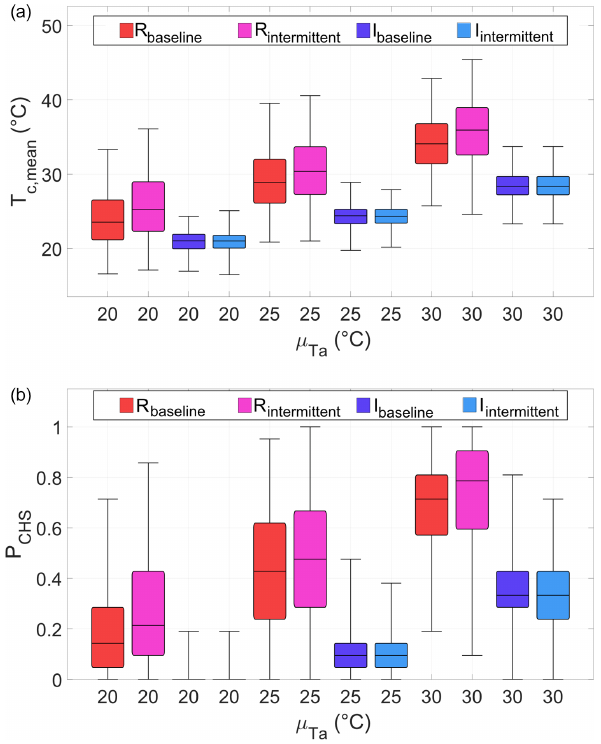
Figure 5. Distribution of mean canopy temperature during anthe- sis ( T c, mean ; (a) ) and percentage of days during which T c is above the threshold temperature for potential heat damage, T th ( P CHS ; (b) ), under three long-term average air temperatures µ T and different precipitation and irrigation scenarios (colors). In each group of four boxes, from left to right, R baseline and R intermittent represent rainfed cropping, respectively, under baseline precipita- tion ( α p = 8 . 2mm; λ p = 0 . 2d − 1 ) and more intermittent precipita- tion ( α p = 23 . 5mm; λ p = 0 . 07d − 1 ). I baseline and I intermittent refer to stress avoidance irrigation under the same precipitation regime of the corresponding rainfed cases. For each climatic scenario, 500 simulations of 21d each were run. The horizontal black lines are the median values. The boxes extend from the first to the third quartile; whiskers cover the whole